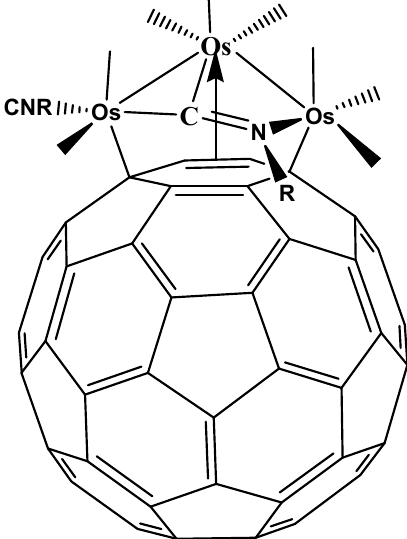
Figure 3. Model of a compound with η 1 hapticity occurring in a single bond